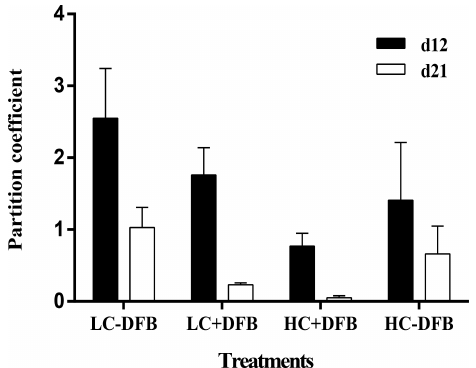
Figure 4. The Fe partition coefficients (the molar ratio between particulate and dissolved concentrations) in the different meso- cosm treatments. LC: ambient CO 2 (390µatm); HC: increased CO 2 (900µatm). -DFB and +DFB are with no DFB addition and with a 70nM DFB addition, respectively, on day 12 and day 21. Bars are means of measurements in three independent mesocosms ( n = 3), except for LC-DFB, where n = 2. Error bars indicate